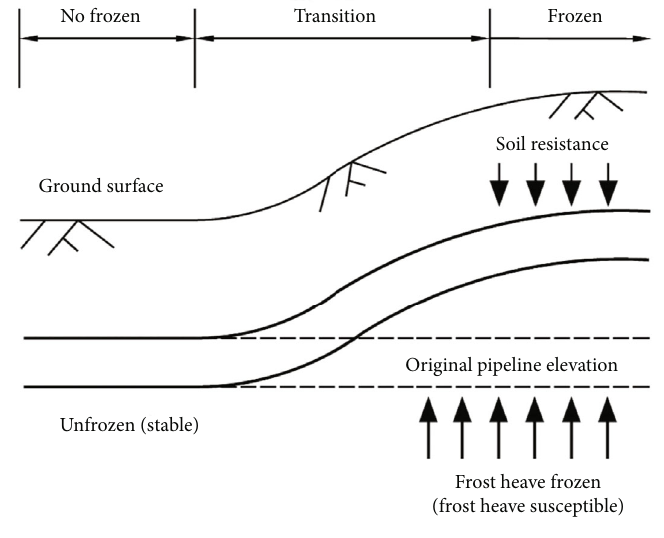
Figure 3: Di ff erential frost heave along a